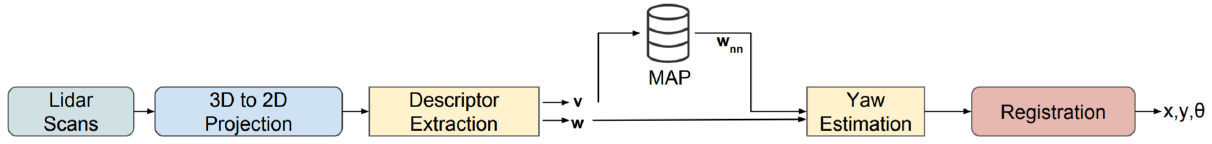
Figure 31. The methodology [84] of oriented recognition from 3D point